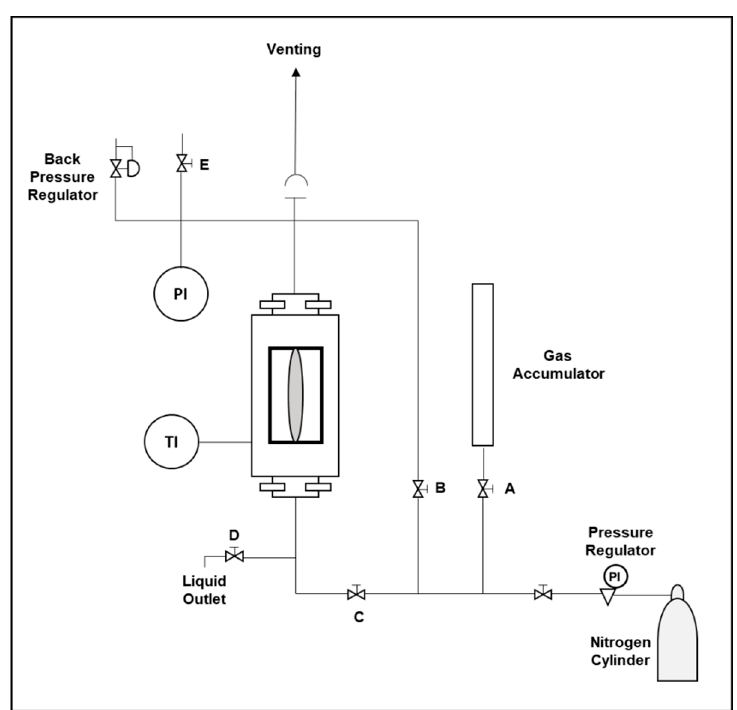
Figure 2. Schematic diagram of the high-pressure view chamber setup for the foam stability test. A and B are ball valves; C, D, and E are needle valves. PI and TI represent pressure gauge and thermocouple, respectively.